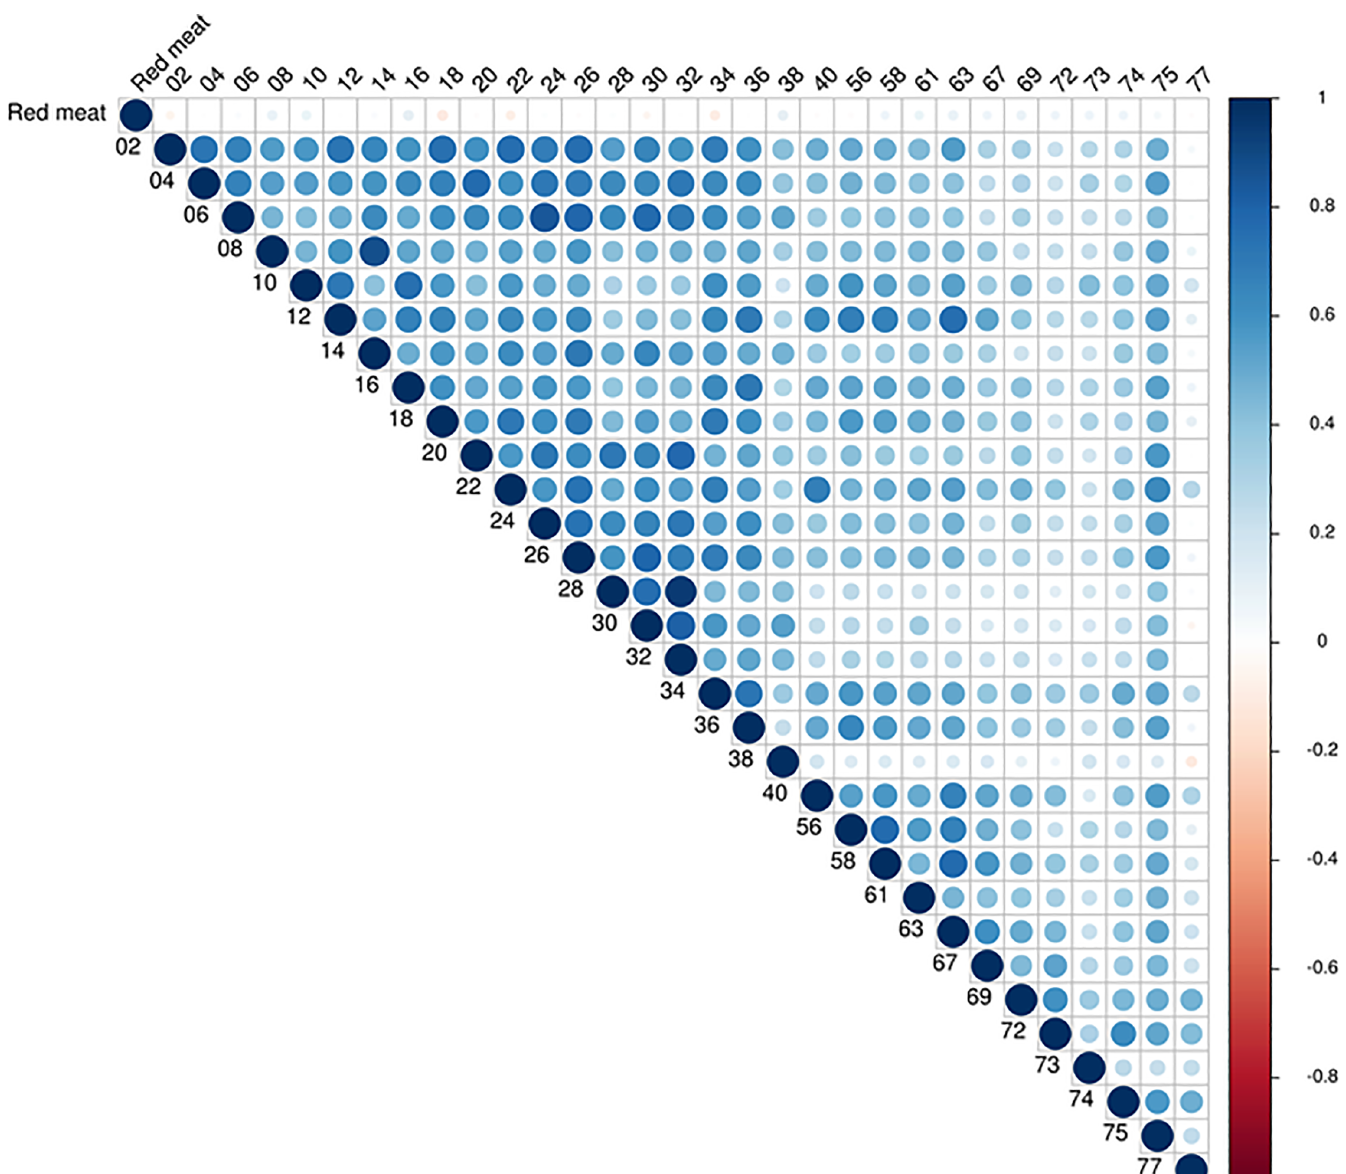
Fig 6. No correlation in heatmap matrix of antibodies against 31 individual Neu5Gc-glycans and red meat consumption in the EPIC-Norfolk samples studied for CRC Risk. The top and left side of the figure represents the individual glycans on the microarray, with each number representing the glycan ID. Each colored dot represents the correlation between the anti-Neu5Gc IgG against the individual glycans and red meat consumption. Black represents a correlation of 1, shades of blue are between 0 and 1, while shades of red are correlations between 0 and -1.